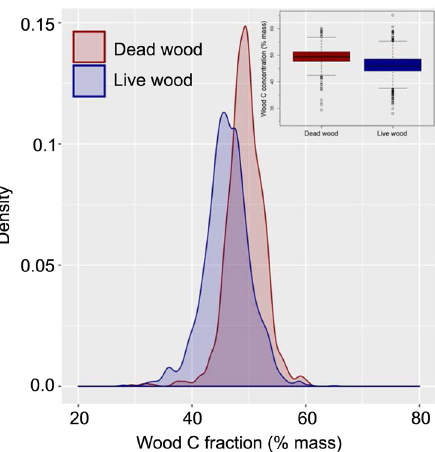
Fig. 1 Carbon fractions (CF) in dead vs. live wood in a global wood CF database. Histograms correspond to kernel density estimates fi t for CF estimates from dead ( n = 973) and live wood ( n = 2233) separately, with the corresponding boxplots in the inset showing medians (solid center lines), 25 – 75th percentiles (boxes), outliers (points), and 5th and 95th percentiles